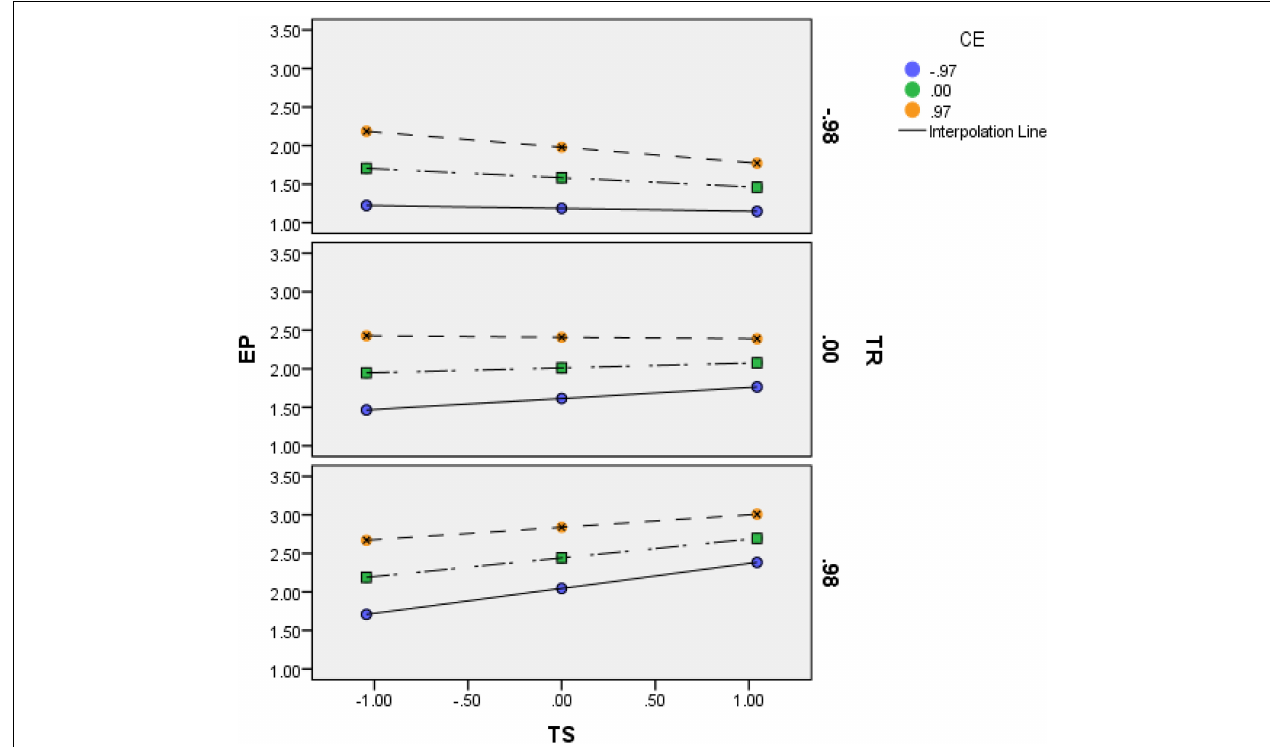
FIGURE 4 | Three-Way Interaction Graph. TS, Techno Stress; CE, Creative Self-efficacy; TR, Training; EP, Employee Performance.